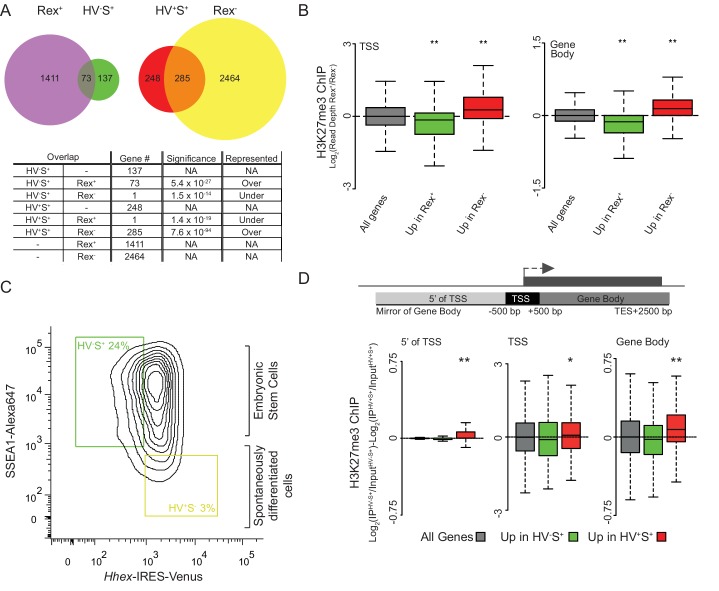
More pronounced changes in H3K27me3 levels are observed in differentiating cells.(A) Venn diagrams showing the overlap of genes with elevated expression in Rex+ and HV-S+ ESC populations (left) and elevated expression in Rex- and HV+S+ (right) ESC populations. Numbers of overlapping genes are given for each comparison with significant over/under representation determined using a Fisher’s test. (B) Boxplots showing the ratio of H3K27me3 ChIP-seq signal between Rex+ and Rex- ESC populations for TSS (left) and gene body (right) for all genes (grey), genes upregulated in Rex+ (green), and genes upregulated in Rex- (red). Two-sample permutation tests (oneway test) were used to compare the H3K27me3 ChIP-seq signal between all vs. differentially expressed genes. P values of < 0.01 are indicated** (all indicated p values are < 2.2 x 10–16). (C) FACS density plot showing the gating used to isolate the Epi-primed (HV-S+; green gate) and spontaneously differentiated PrEn (HV+S-; yellow gate) populations from the Hhex-Venus reporter ESCs co-stained for the pluripotency marker SSEA1. (D) Schematic representation of the stratification used to bin H3K27me3 signal with respect to genes (upper panel) and boxplots showing the ratio of H3K27me3 ChIP-seq signal between HV-S+ and HV+S- ESC populations (presented as in Figure 1G). Significance was tested and indicated as for panel B (indicated p values from left to right as shown are 0.004, 0.02 and < 2.2 × 10–16).